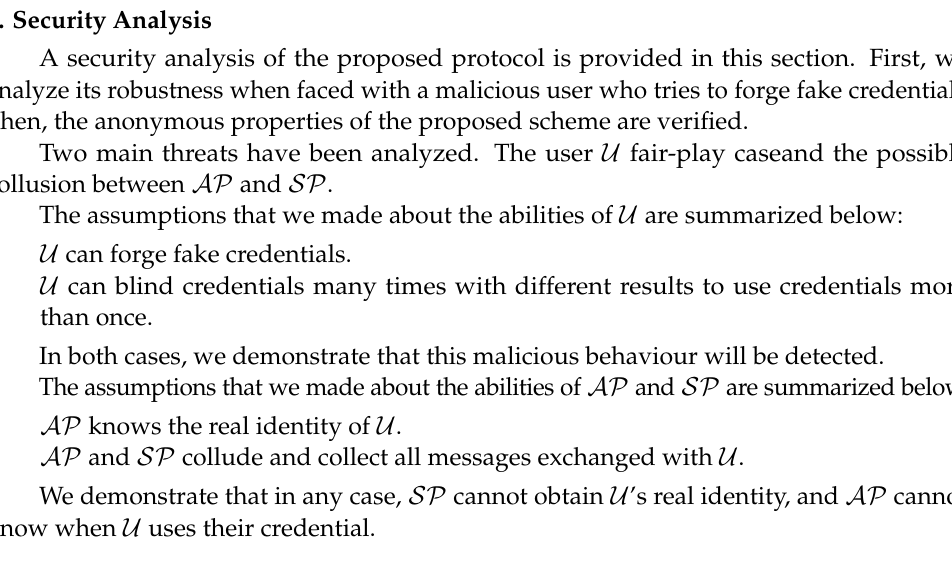
and during the credential presentation U SP